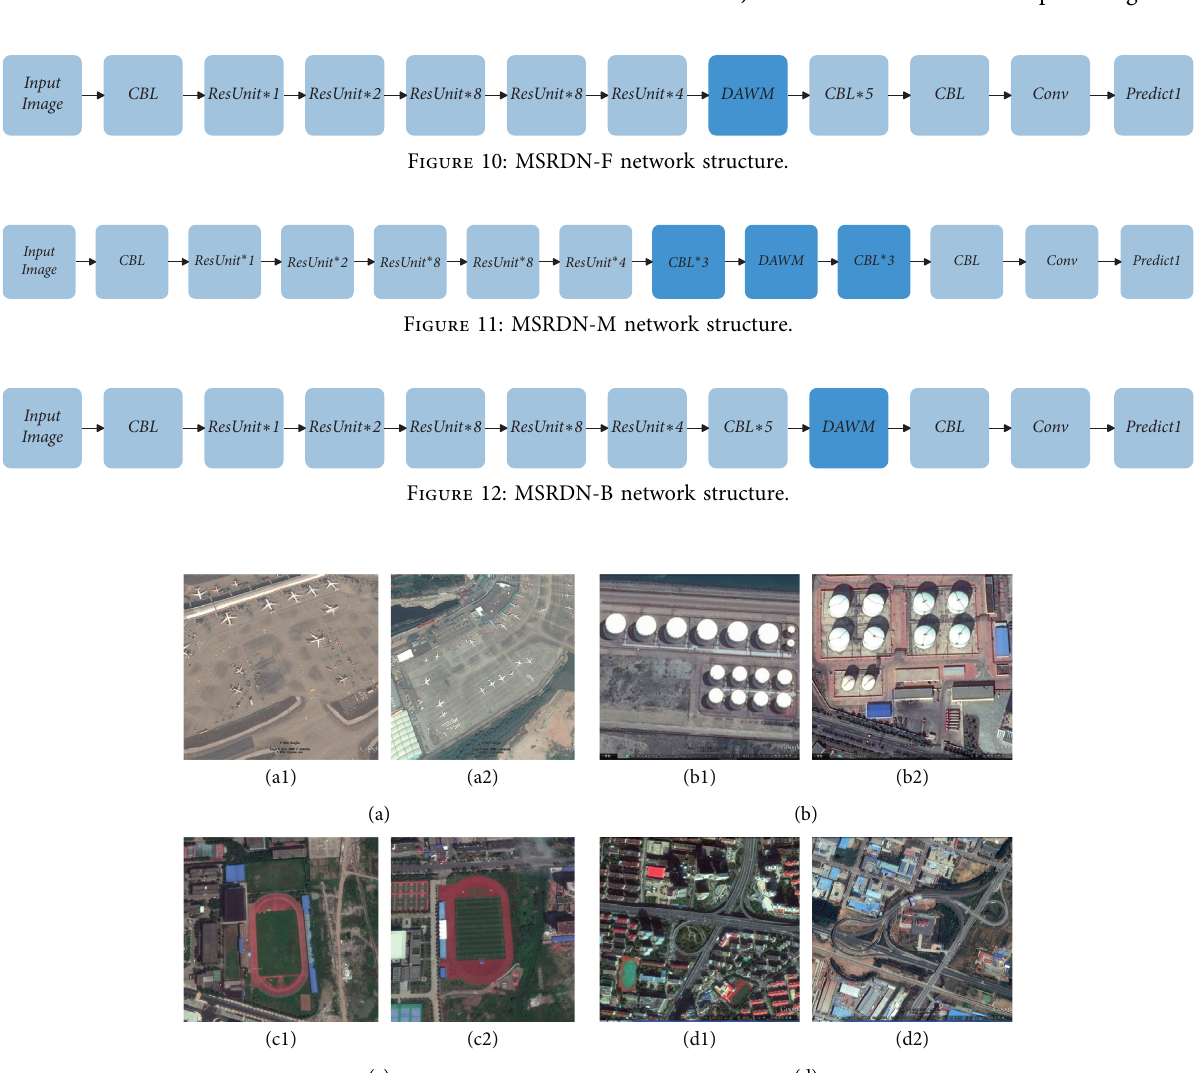
Figure 13: The samples of the dataset. (a1, a2) Aircraft targets; (b1, b2) oil tank targets; (c1, c2) playground targets; (d1, d2) overpass targets.